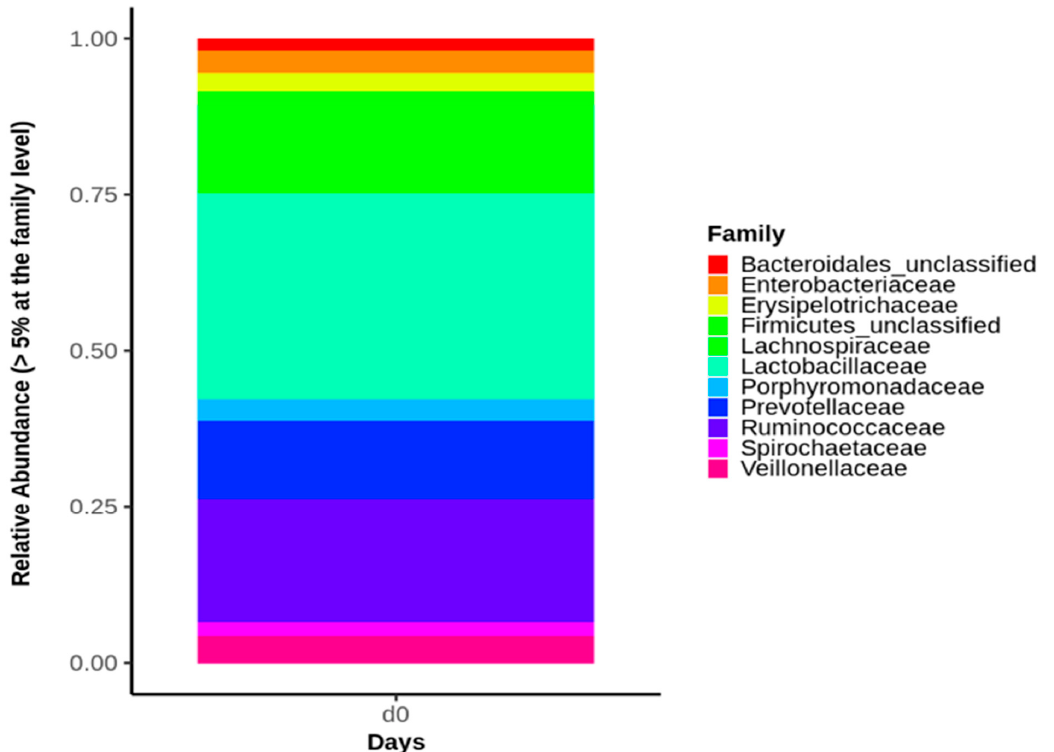
Figure 2. Relative abundance of the major bacterial families identified in the fecal microbiota of the four piglet groups at Day 0 (D0). Only bacterial families representing at least 5% of piglet fecal microbiota are shown.